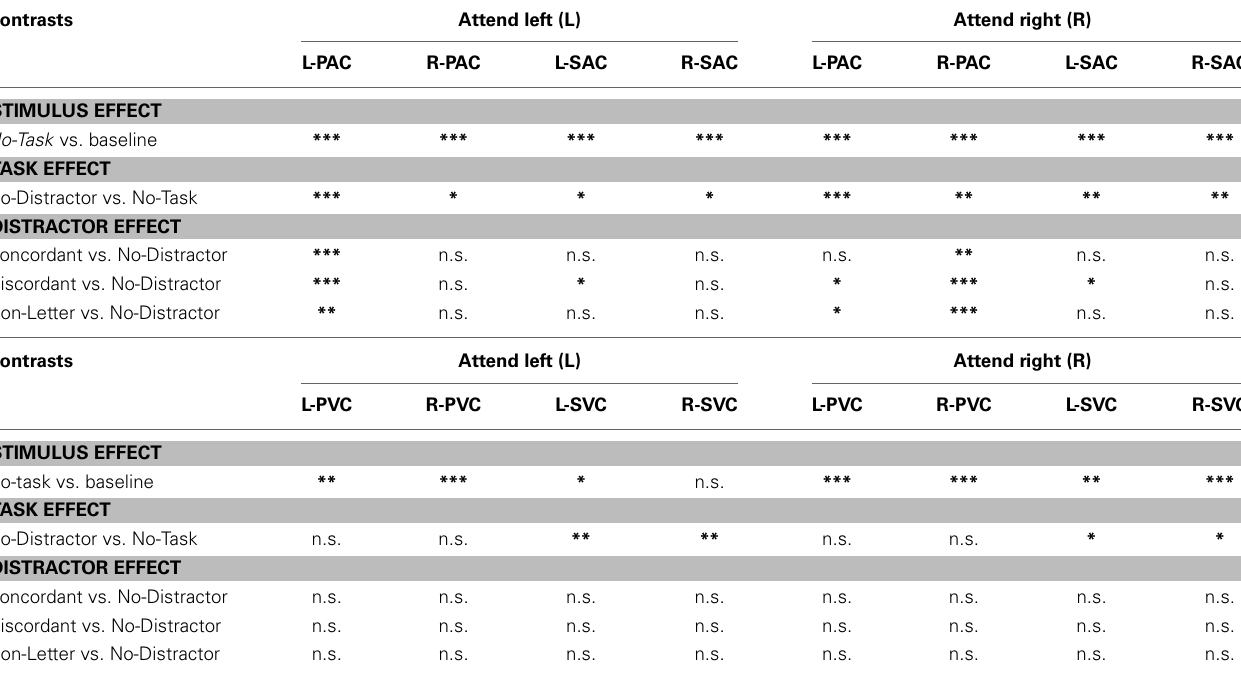
Table 2 | Significance of the contrasts of the sensory ROIs, for the Attend Left (L) and Attend Right (R) experimental conditions.